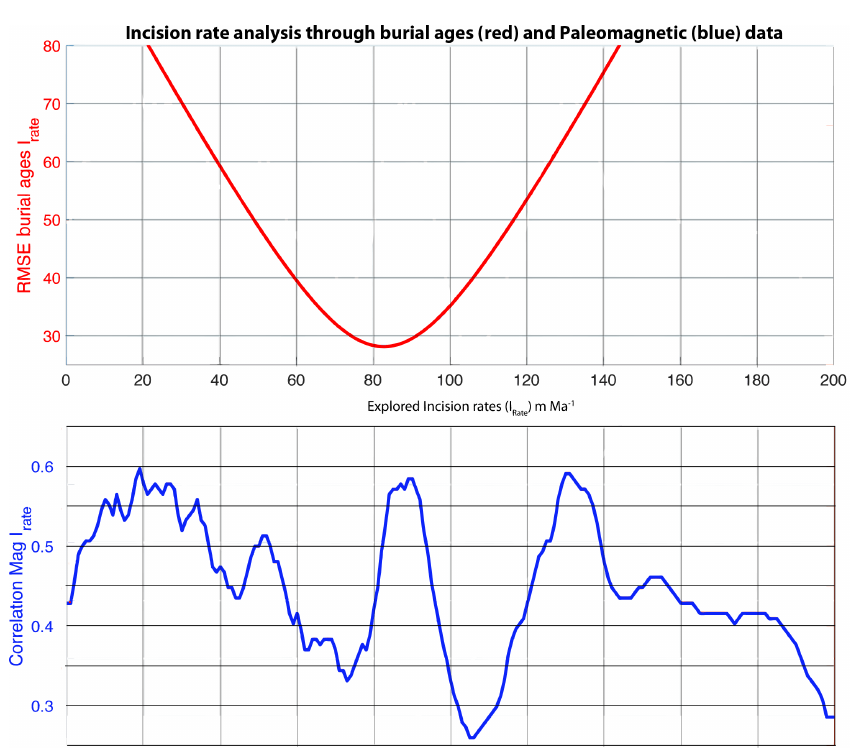
Figure 8. Best incision rates based on paleomagnetic data (blue) and burial ages (red). The blue curve is the normalized smoothed (10mMa − 1 sliding window for better visualization) correlation between theoretical and observed polarities. The highest correlation corresponds to the best incision rates. The red curve is the RMSE for the linear regression through the burial ages data set shown on Fig. 4.